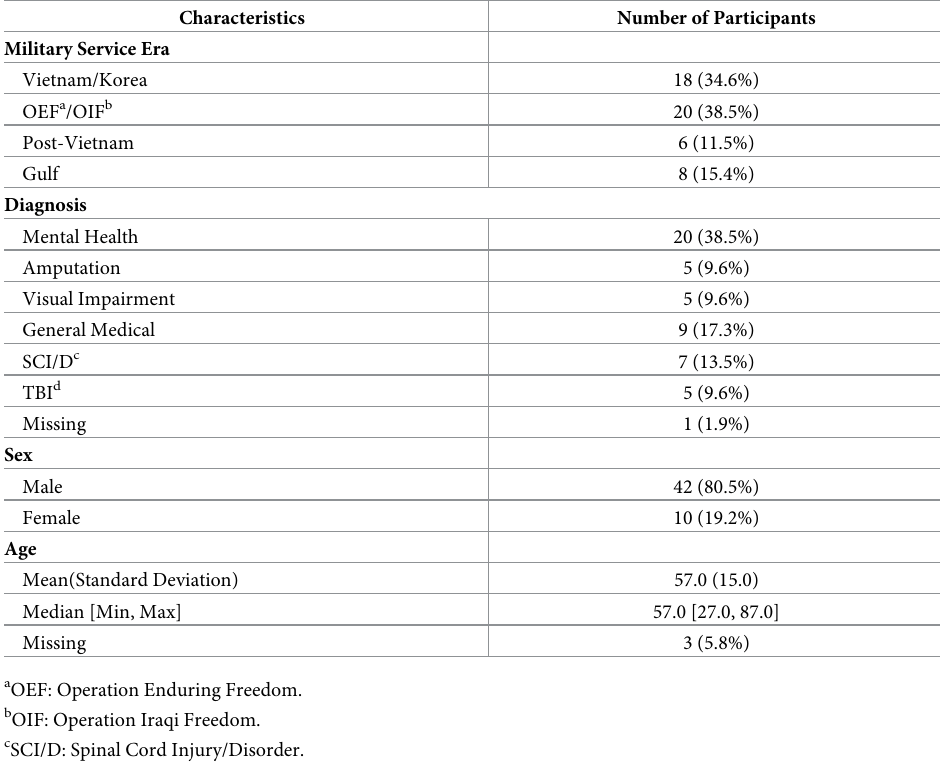
Table 1. Participant